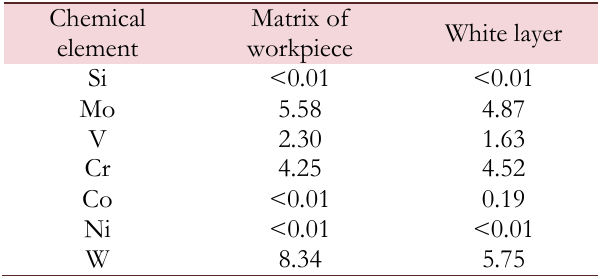
Table 1: EDS analysis of modified workpiece from HS 6-5-2